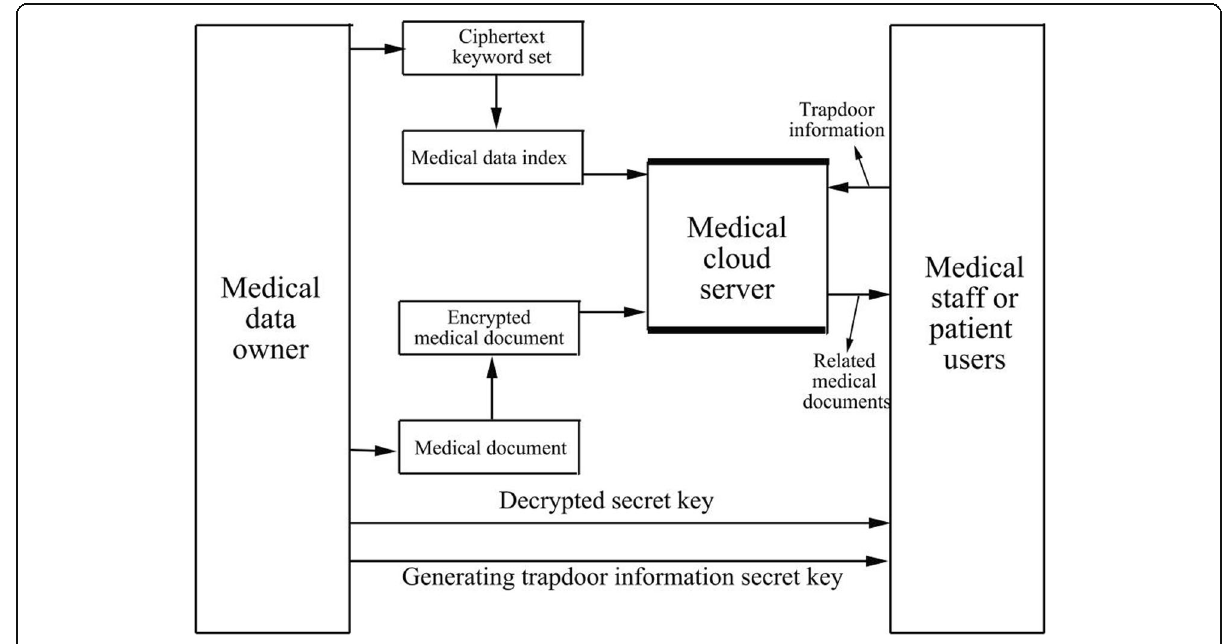
Fig. 6 Symmetric searchable encryption